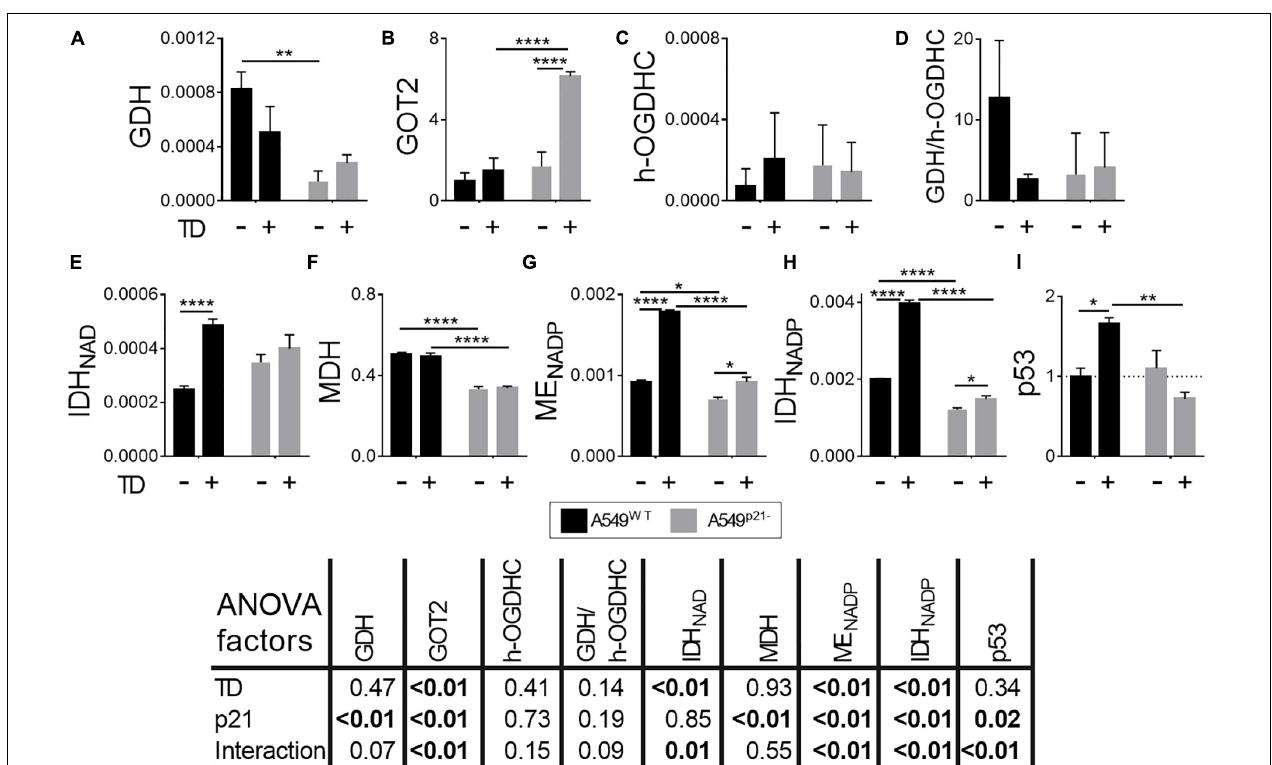
FIGURE 4 | Changes in the levels of the enzymes and p53 in A549 WT and A549 p21 − cells, induced by thiamine deficiency. (A,C,E–H) Activities of the enzymes indicated on Y axes are shown as µ mol · min − 1 · mg − 1 ; (B) protein level of the mitochondrial aspartate aminotransferase (GOT2), arbitrary units; (D) ratio of activities of GDH and endogenous holo-OGDHC (h-OGDHC), assessing the glutamate degradation in the TCA cycle; (I) protein level of p53, arbitrary units. Thiamine deficient (TD) cells were grown for 7 days in thiamine-free medium. The data are obtained from three independent cell cultures. Values are presented as mean ± SEM. Statistical significance of the differences is determined by two-way ANOVA followed by Tuckey’s post hoc test. P -values of the significances of the two factors and their interaction, analyzed by ANOVA, are provided in the table under the graphs. On the graphs, different p-values are shown by asterisks as described in Materials and Methods under Statistical Analysis